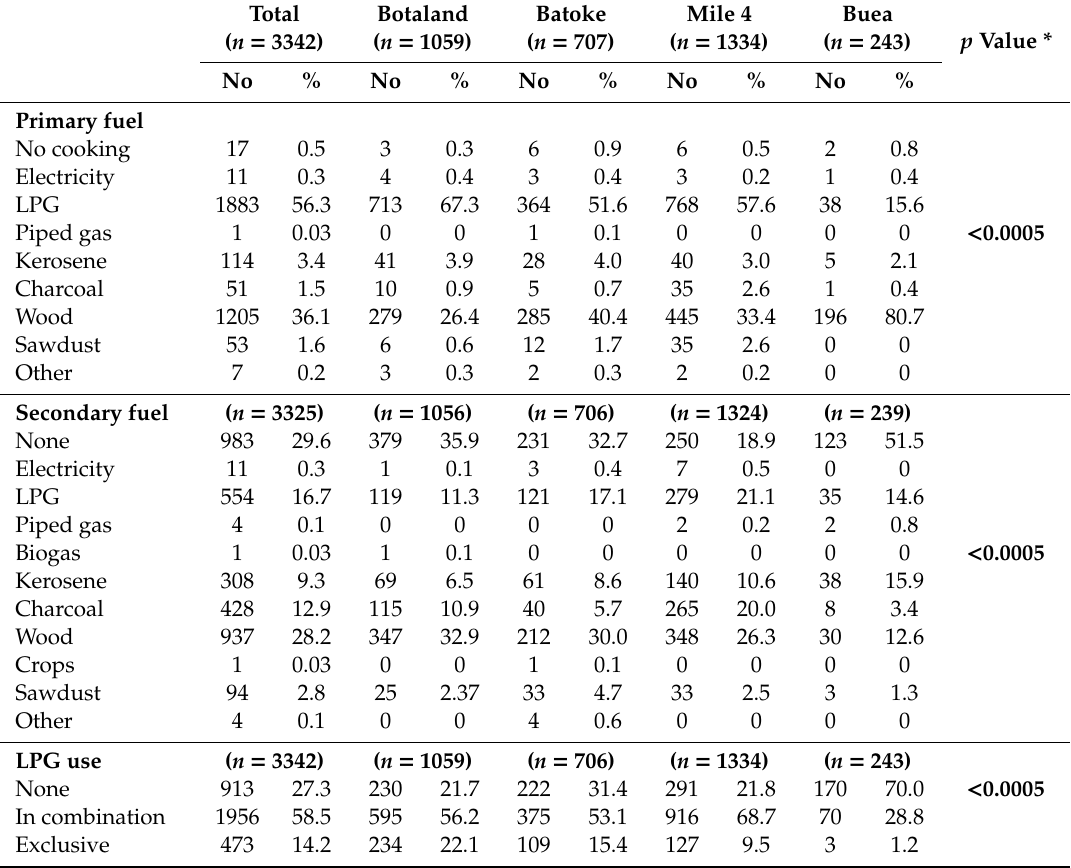
Table 4. Primary and secondary fuels used for cooking and degree of LPG use stratified by community.